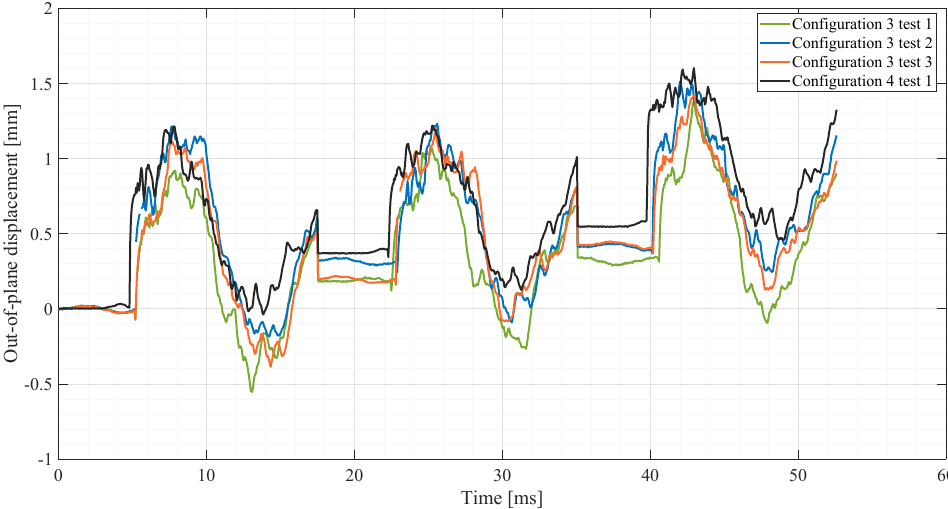
Figure 12. Comparison between configurations 3 and 4 in terms of the out-of-plane displacement of the geometrical centers of the holes formed by the impact of the three FSPs.